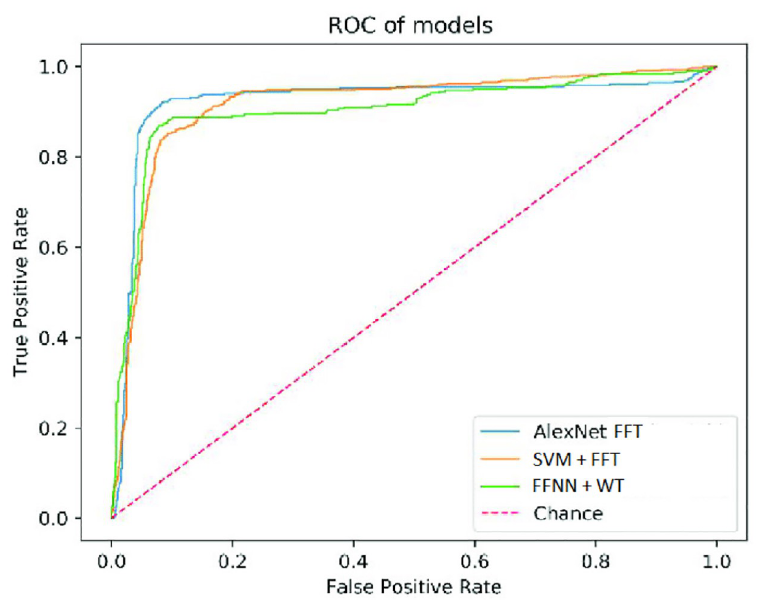
Fig 16. Accuracy as the function of